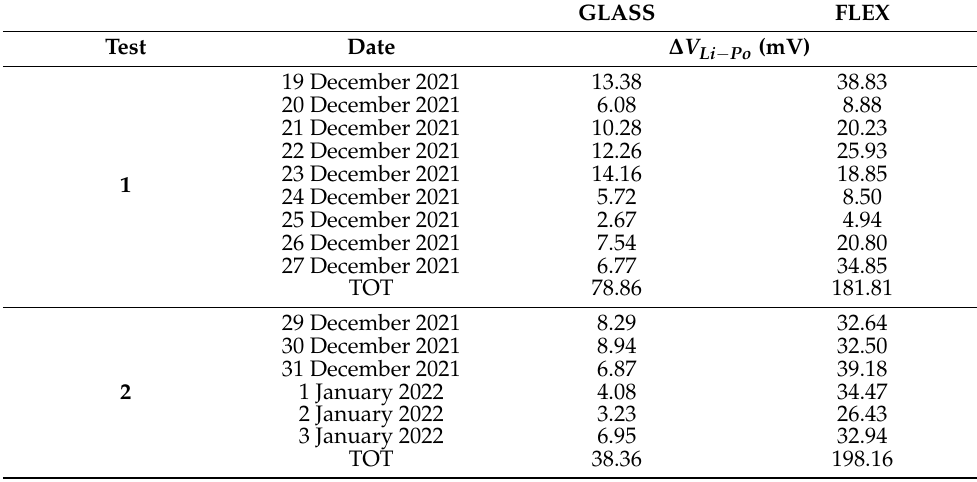
Figure 7. Input voltage V in _ Glass and diffuse intensity measured by the pyranometer (blue line) together with the outdoor solar irradiation as reported by local weather broadcasts (red line) for the first test campaign (( a , b ), respectively) and the second test campaign (( c , d ), respectively). Table 2. Daily net balances obtained as the difference between the final and initial battery voltage levels (i.e., ∆ V Li − Po _ Flex and ∆ V Li − Po _ Glass ) for the two test